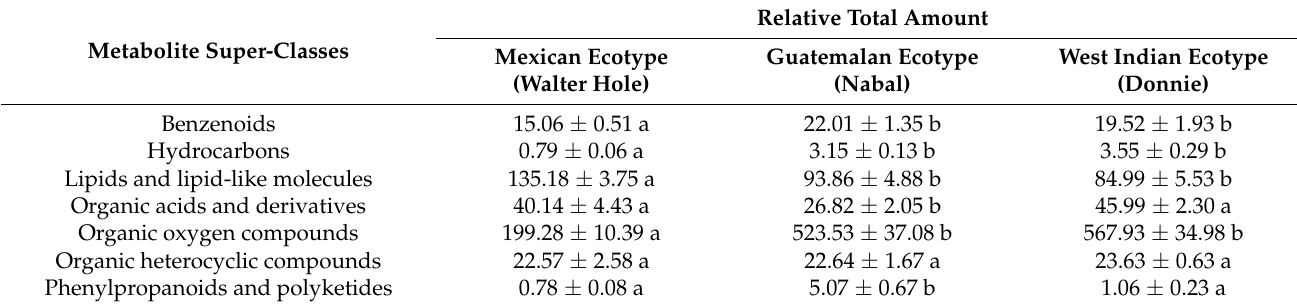
Error bars indicate standard deviation from three biological replicates of each ecotype. Means with the different letters indicate significant differences (Duncan, p ≤ 0.05) among mature avocado mesocarp of three